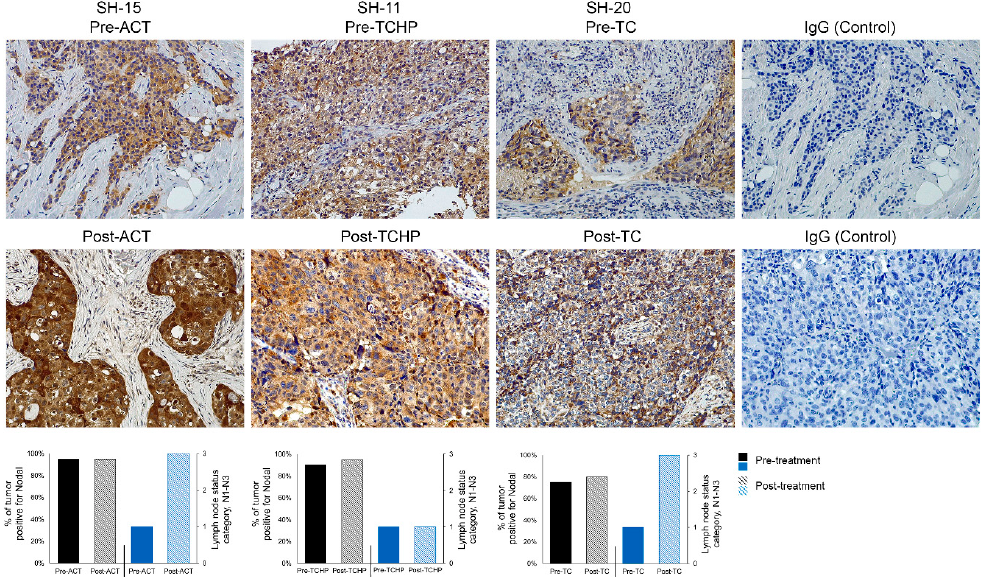
Figure 2. The presence of the Nodal protein (brown color) in breast cancer patient tumor sections, pre ‐ and post ‐ current ‐ standard ‐ of ‐ care ‐ treatments (ACT, TCHP, and TC), was examined by immunohistochemical staining with IgG used as a control for non ‐ specific staining (20× original magnification). Bar graphs below the immunohistochemistry (IHC) data depict the percent of tumor positive for Nodal pre ‐ and post ‐ therapy (relative to where 100% represents every tumor cell expressing Nodal) correlated with the lymph node status categories N0–N3 (see Table 1 and Table 2 legends).